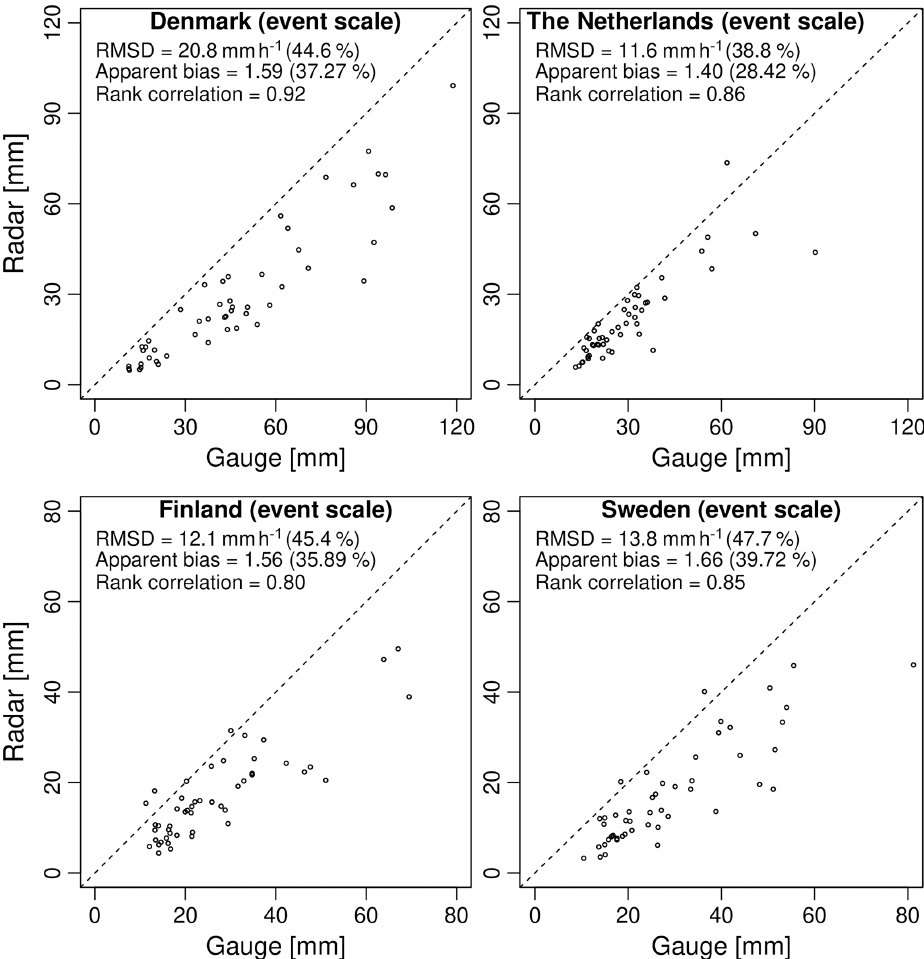
Figure 6. Radar versus gauge accumulations (in millimeters) at the event scale for each country (i.e., one dot per event). The dashed line represents the diagonal. Table 3. Summary statistics for the highest aggregation timescale (all 50 events combined). Average intensity for gauges and radar µ g and µ r , standard deviations σ g and σ r , G / R ratio, coefficient of variation, scale parameter σ ε and model bias β .